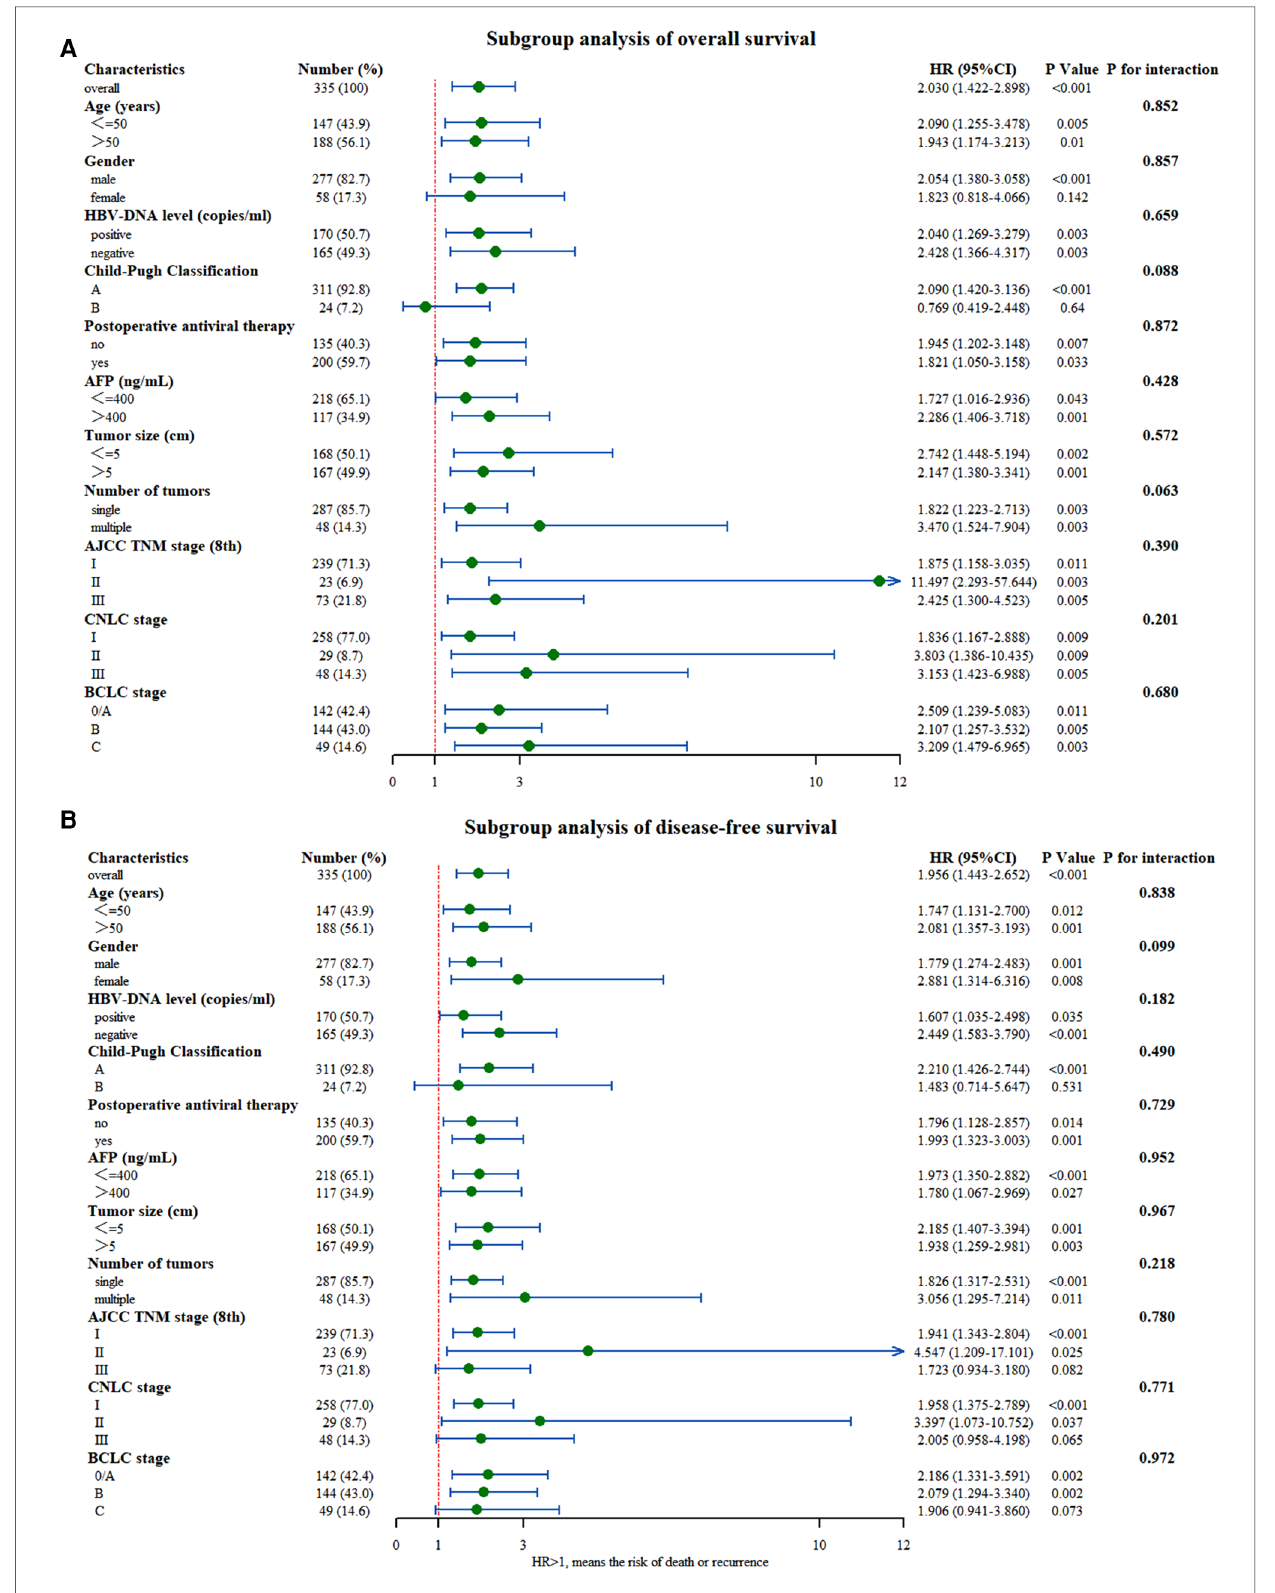
FIGURE 3 Subgroup analysis of ( A ) overall survival and ( B ) disease-free survival between the two groups with and without